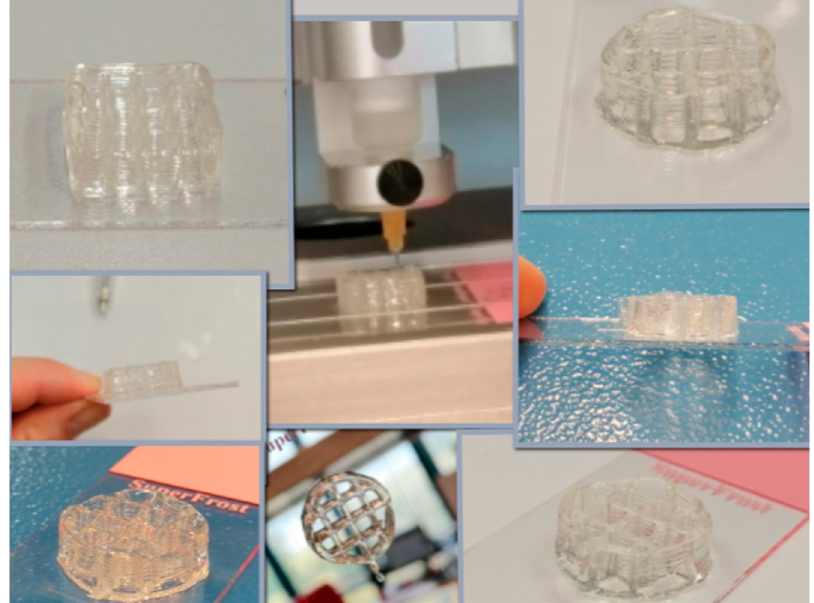
Figure 10. 3D Printing constructs manufactured using salecan hydrogel inks (selected images for 10% wt salecan formulations).